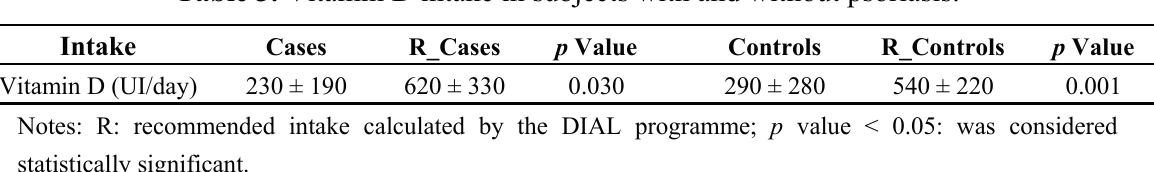
Table 3. Vitamin D intake in subjects with and without